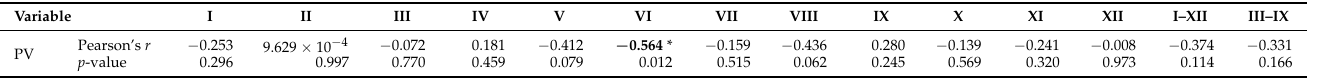
Table 5. Correlations between the averages of the temperature (I–XII) and pastoral value (PV) in ex-arable grassland from Gr ă dinari (period 2003–2021).